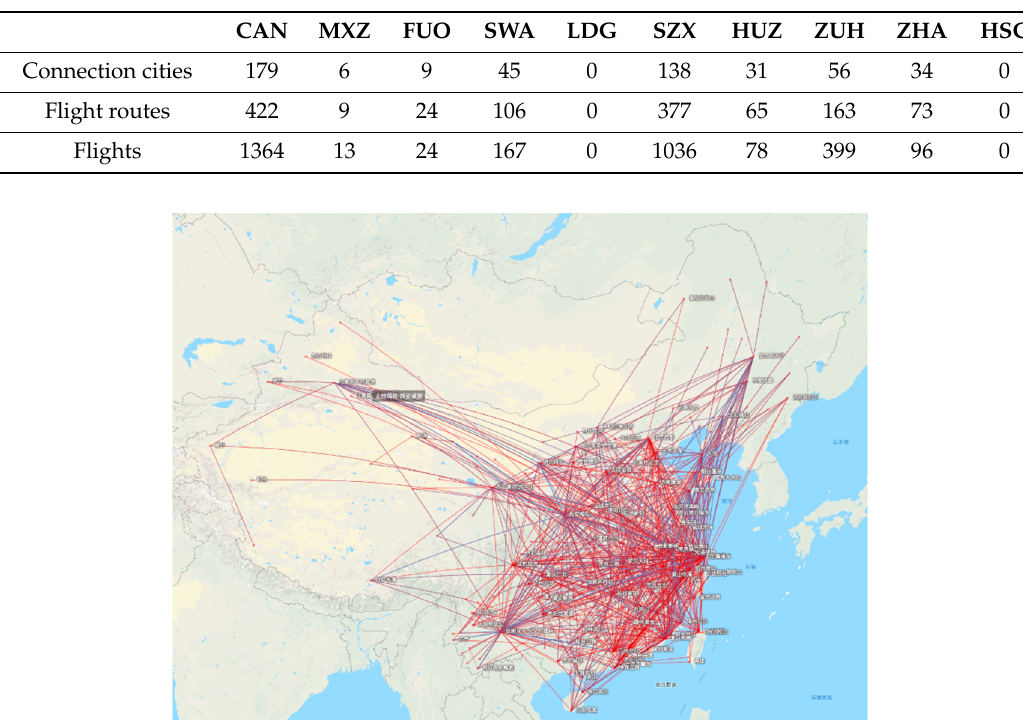
Table 4. Statistics of Guangdong Airport Routes on June 25, 2019.